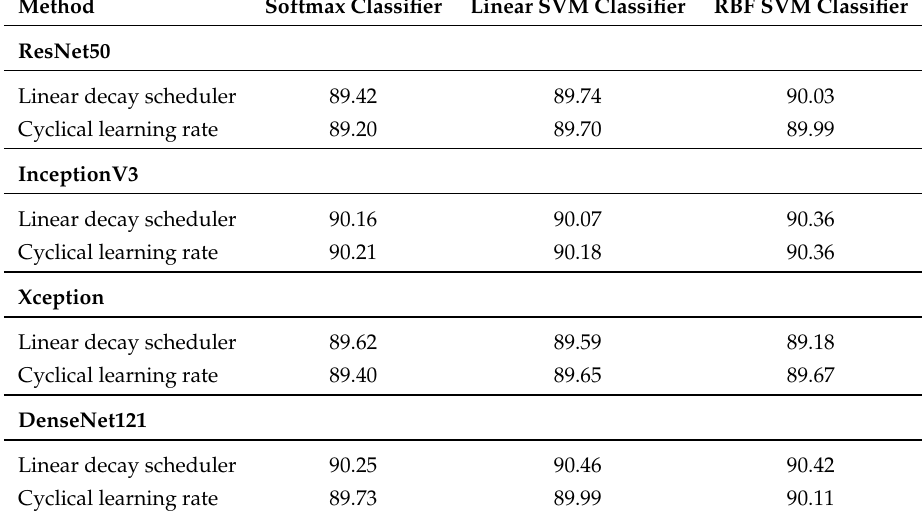
Table 5. Overall accuracy (%) of the proposed method with a 10%/90% train/test ratio of NWPU-RESISC45 data set. The bold text highlights the best accuracy per classifier.